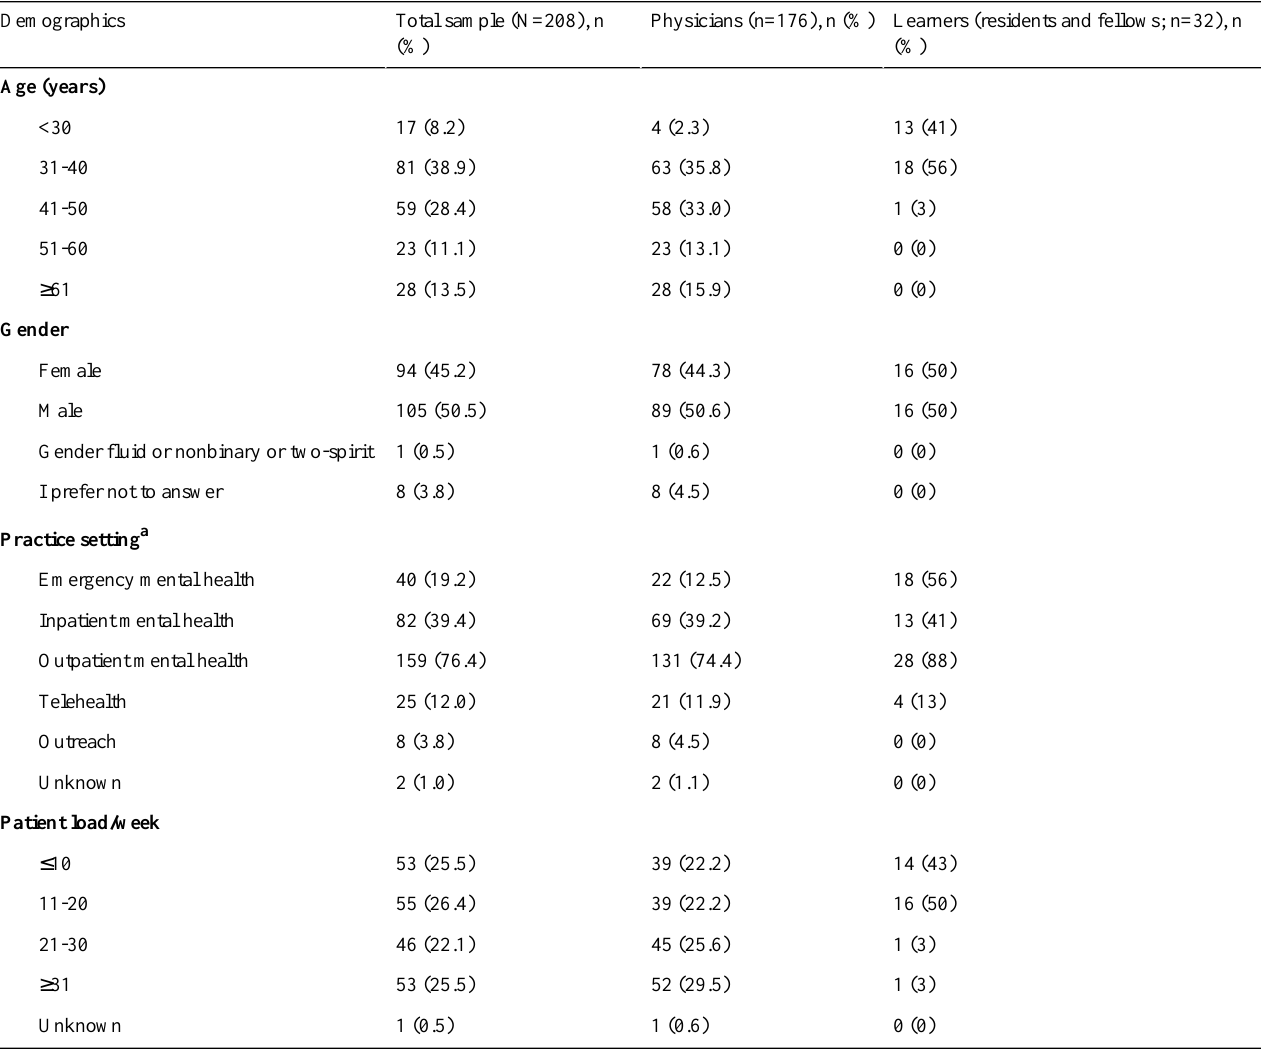
Table 2. Demographic and practice characteristics, by experience